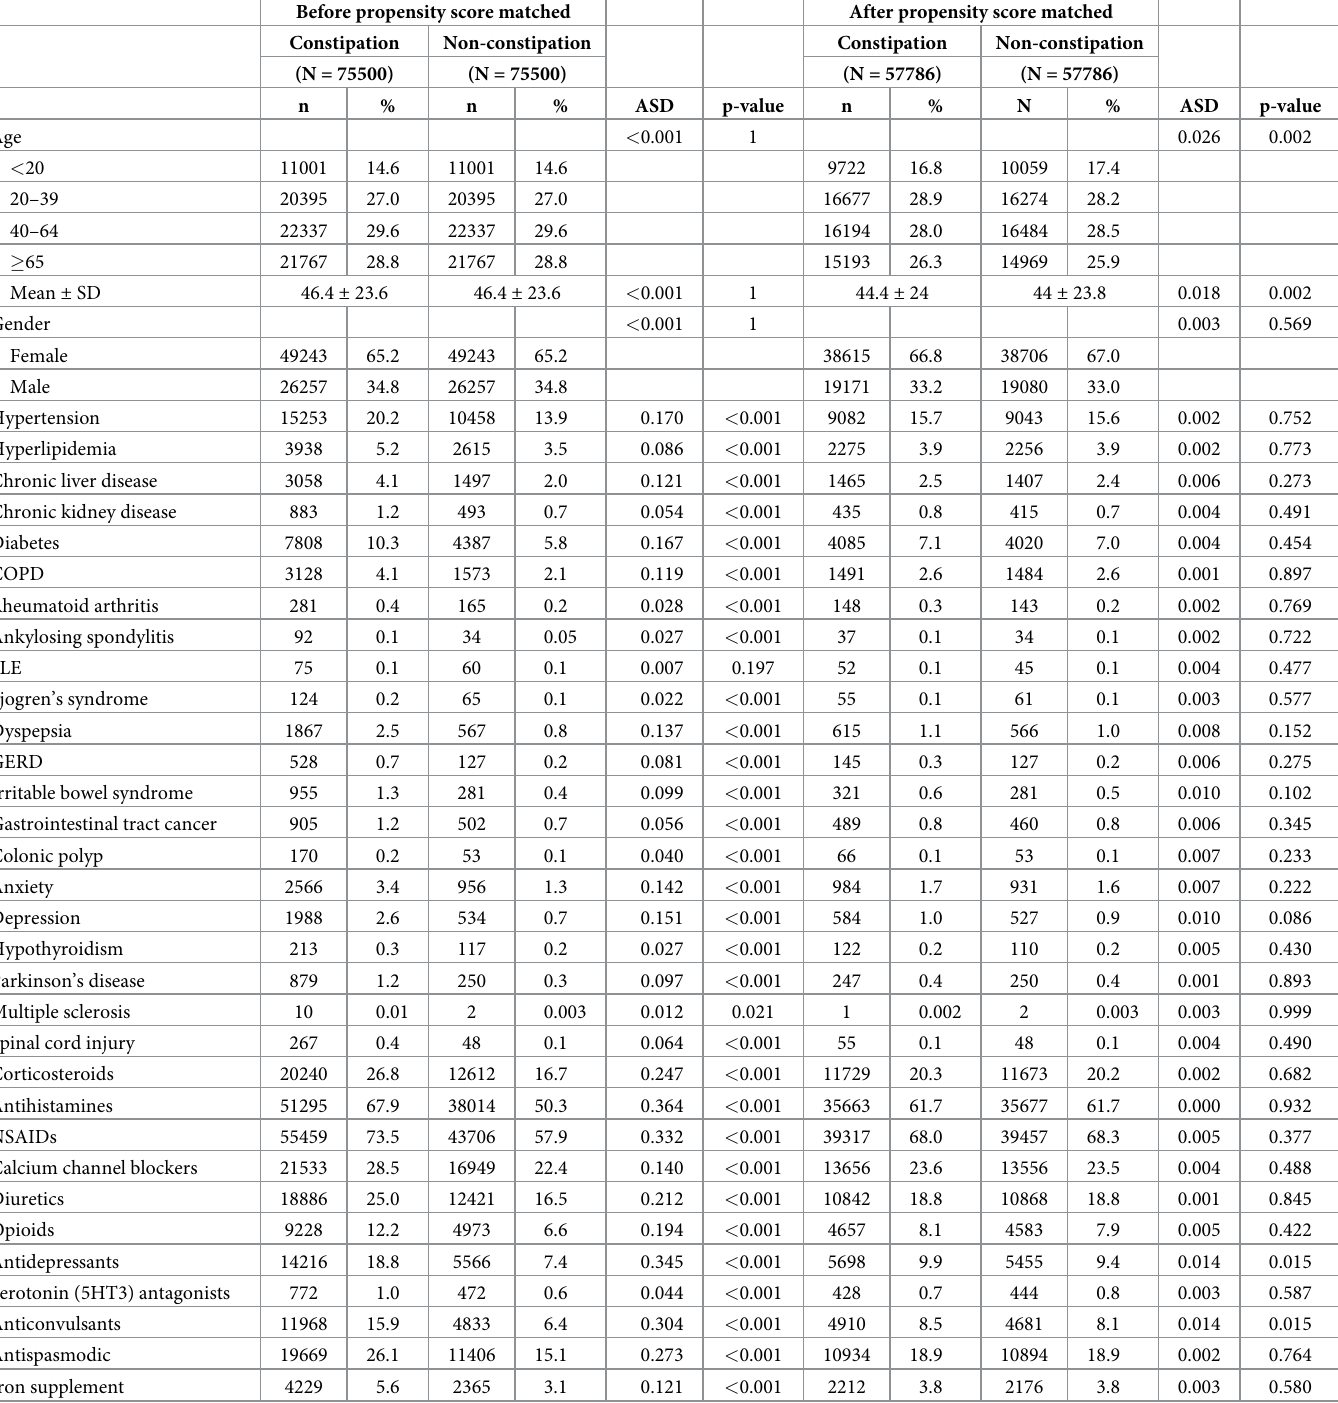
Table 1. Demographic characteristics of constipation group and non-constipation